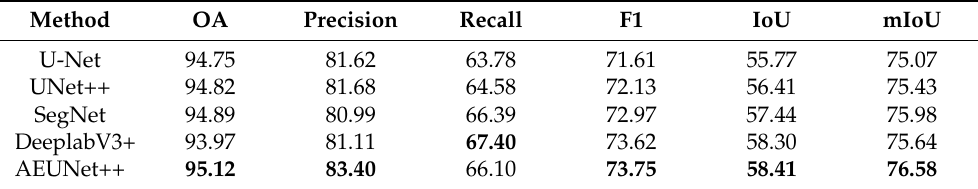
Table 1. Quantitative comparison of OA, Precision, Recall, F1, IoU and mIoU for the Massachusetts buildings data set.